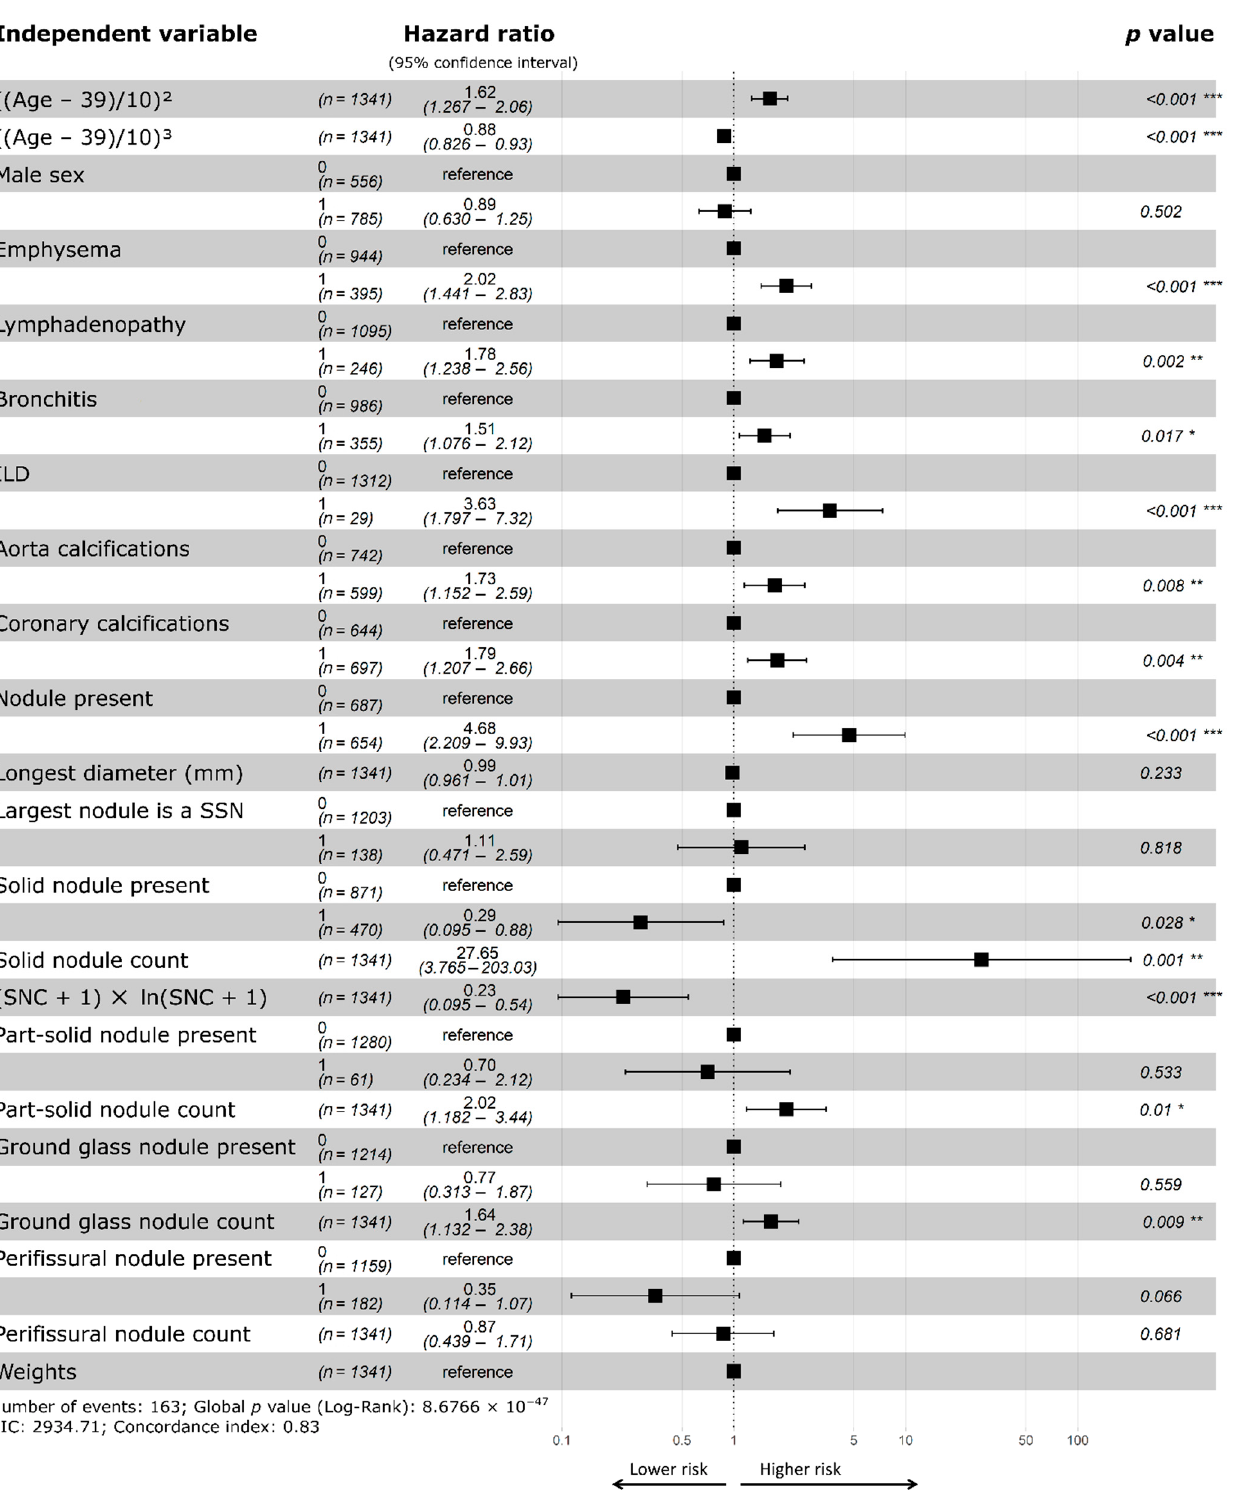
Figure 2. Forest plot of multivariable Cox regression. For binary variables, 0 (reference value) indicates absence and 1 indicates presence. For continuous variables (i.e., age, diameter, nodule counts), the hazard ratio refers to each unit increase. A hazard ratio greater than 1 indicates that the presence of the variable increases the risk of lung cancer incidence; conversely, a value less than 1 indicates that the presence of the variable reduces the lung cancer incidence risk. * p value < 0.05; ** p value < 0.01; *** p value < 0.001; ILD, interstitial lung disease; N, number of; PFN, perifissural nodule; SNC, solid nodule count; SSN, subsolid nodule.